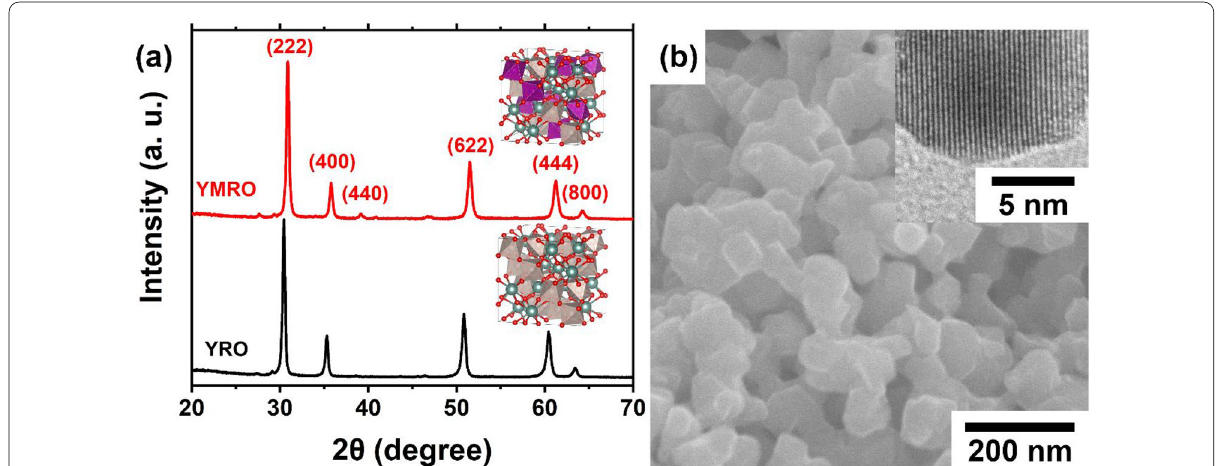
Fig. 1 a XRD patterns and the coresponding illustrations of crystal structure (inset), b SEM and TEM (inset) images of YMRO. Color code: Y (teal), Ru (gray), Mn (purple), and O (red). The XRD pattern for YRO was inlcuded for